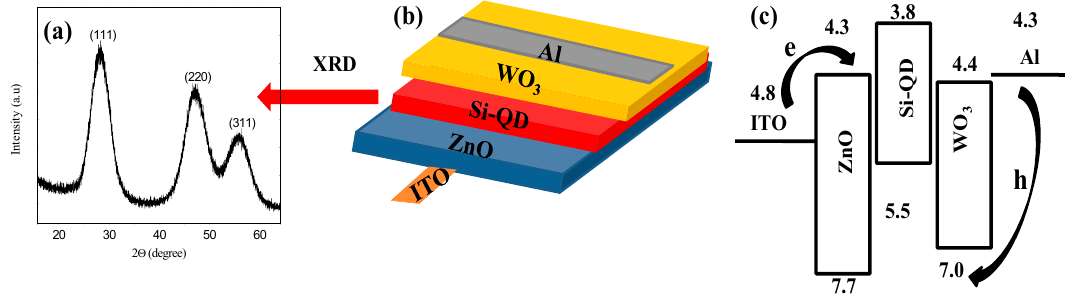
Figure 1. ( a ) X-ray powder diffraction pattern of Si QD, ( b ) a schematic representation of the red-light emitting Si QLED with an inverted device structure, and ( c ) the corresponding flat band diagram.